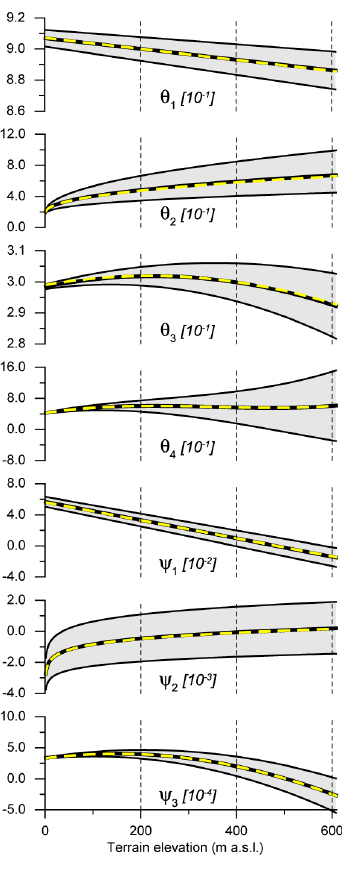
Fig. 3. Parameter functions θ 1 − 4 (z) and ψ 1 − 3 (z) of the albedo model according to Table 2. The broken yellow lines represent the functions of the IAM. The solid black lines and the grey uncertainty ranges represent the functions of the FAM. For better comparability, all parameter functions are displayed in the same order of magni- tude. The conversion factor to the original values is given in italic brackets behind the parameter symbol of each